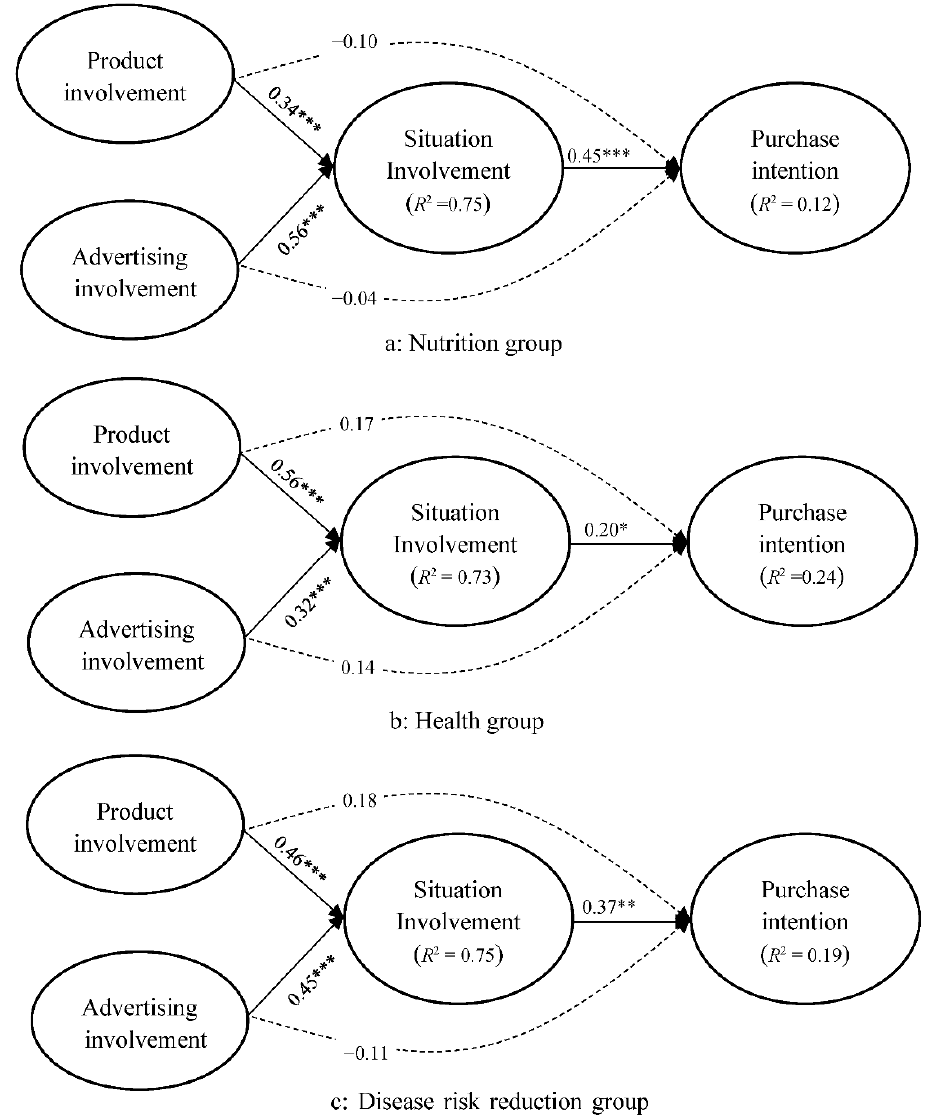
Figure 4. Moderation model for purchase intention ( n = 1046) in the nutrition claim (( a ), n = 350), health claim (( b ), n = 350), and disease risk reduction claim groups (( c ), n = 346) * p < 0.05, ** p < 0.01, *** p < 0.001.